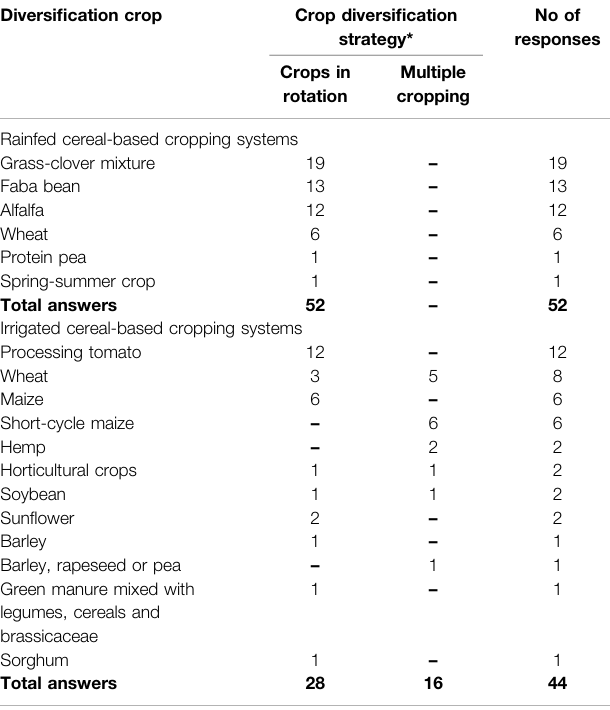
TABLE 9 | List of the most adequate crops selected for each crop diversi fi cation strategy for both the rainfed and irrigated cereal-based cropping systems by the stakeholders (number of